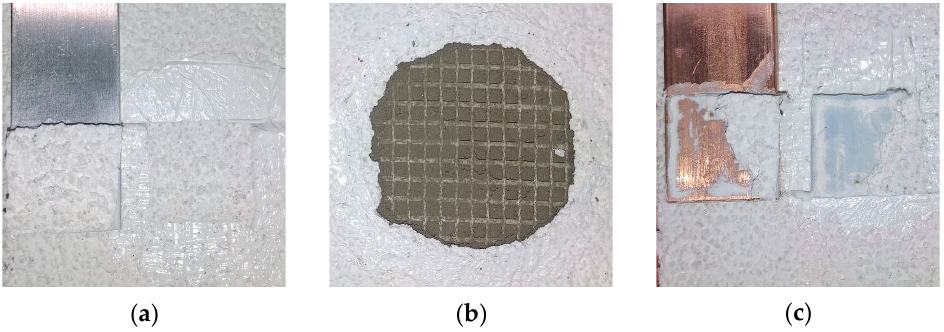
Figure 6. Possible types of destruction: ( a ) tearing of the metal strip including the adhesive from the plaster surface; ( b ) tearing of the plaster including the covering layer of the screed from the layer of reinforcing fibreglass fabric; ( c ) peeling off the adhesive from the copper strip.